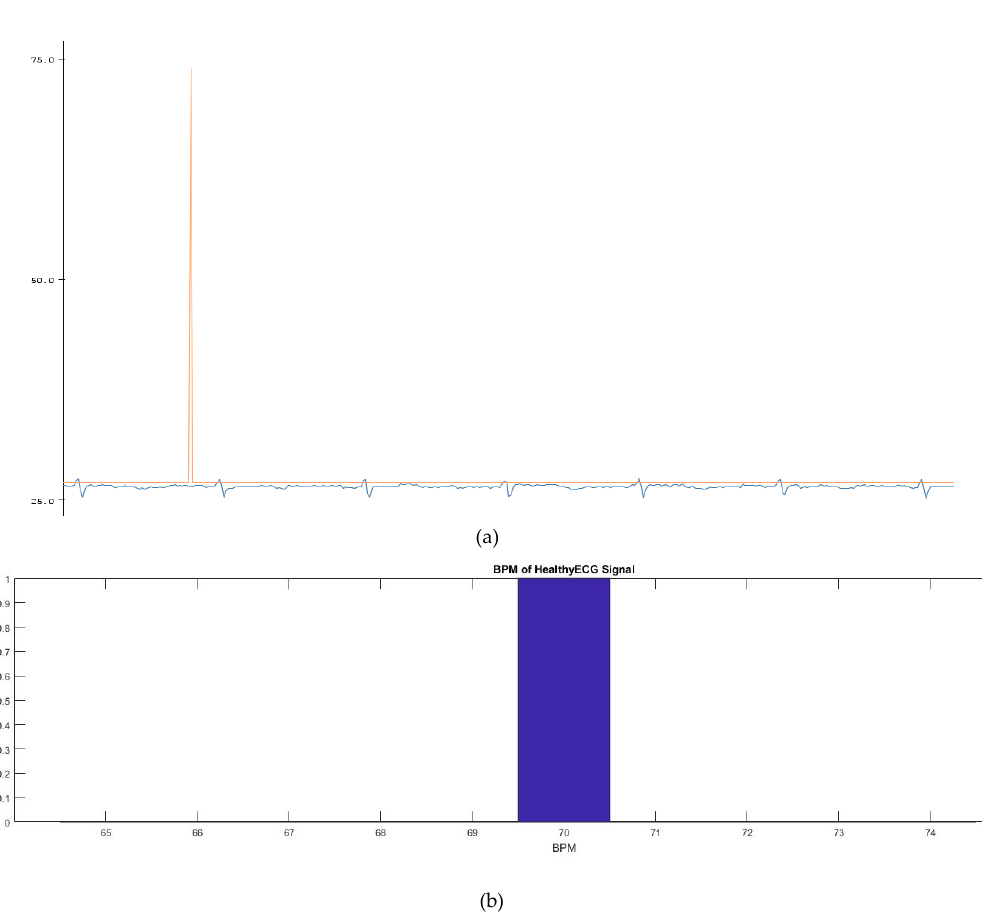
Figure 6. ( a ) Signal acquired from Bitalino ECG sensor and Arduino serial monitor (Red Spike: beats per minute (BPM), Blue: ECG signal. ( b ) BPM data plotted in Matlab (70 BPM). Table 1. The Measurement subroutine used to calculate the BPM.